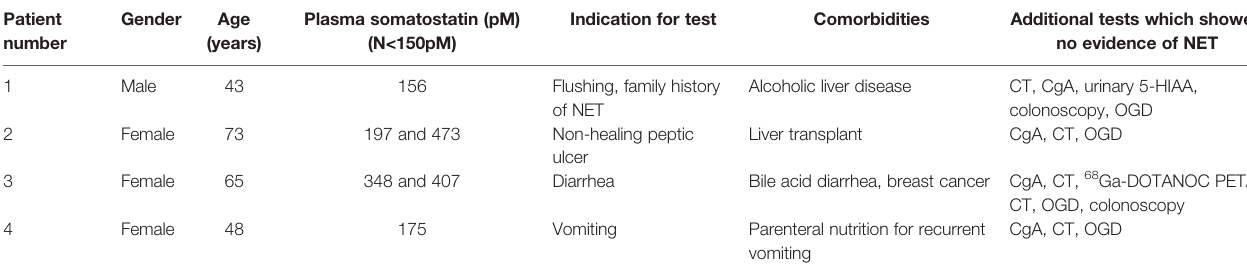
TABLE 3 | Clinical details of patients with raised plasma somatostatin concentrations.